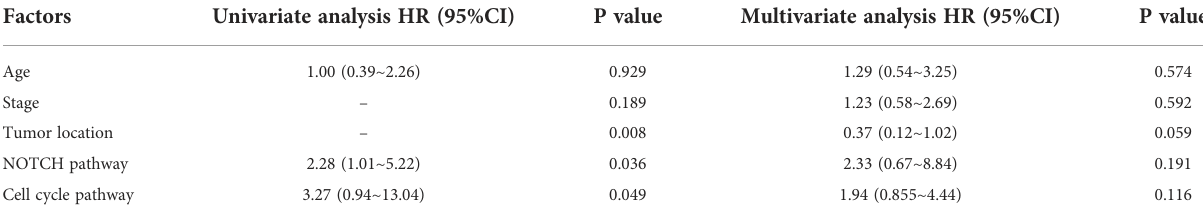
TABLE 3 Univariant and multivariant analysis of patients strati fi ed by small (<5cm) and large ( ≥ 5cm) tumor sizes.